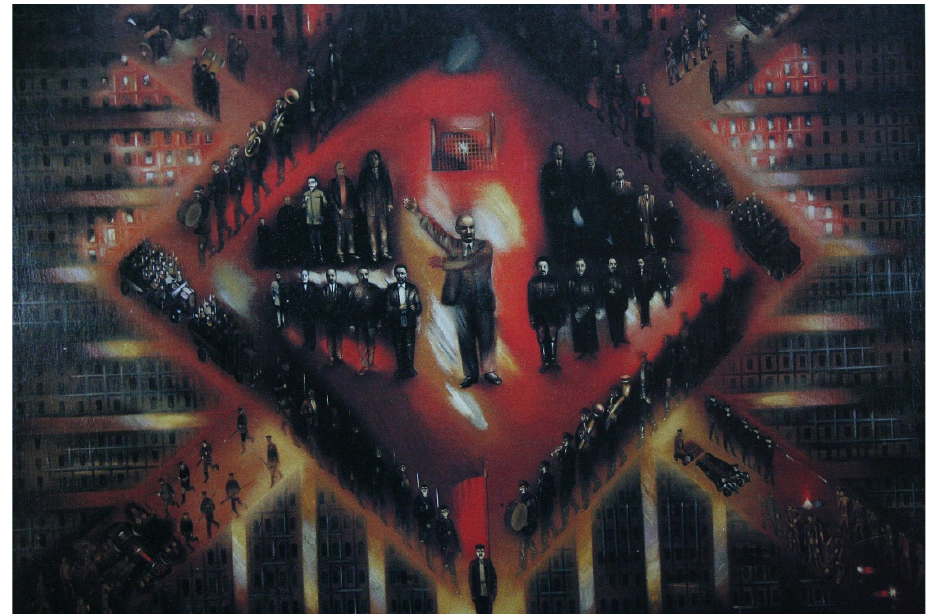
Figure 2. K. Redko. Revolt . 1925.